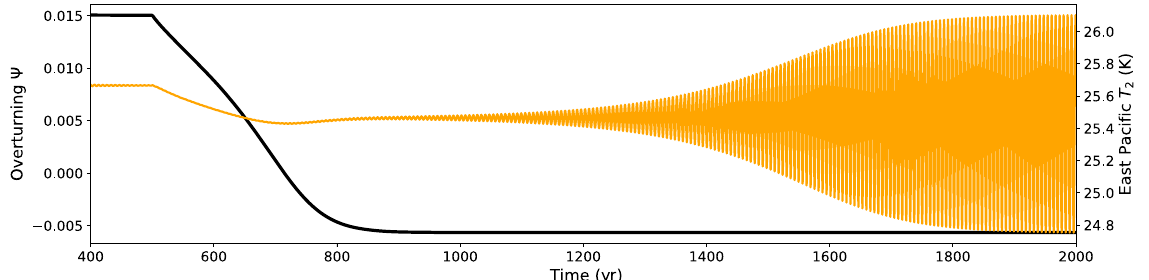
Figure 9. Simulation run of the coupled Stommel–Timmermann model for different model configurations, where the collapse of the over- turning flow function (black) leads to the crossing of a Hopf bifurcation in the eastern equatorial Pacific SST (orange). Parameter values as in Timmermann et al. (2003), with µ = 0 .